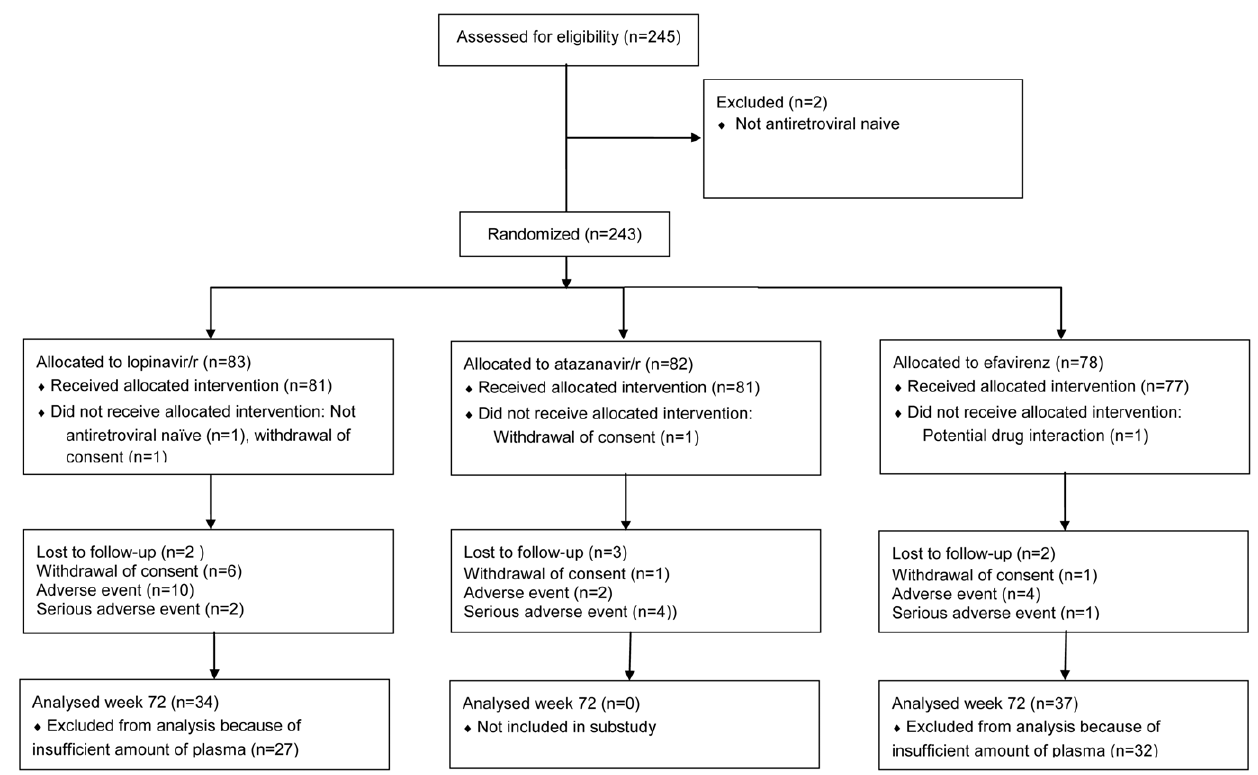
Figure 1. Trial profile and reasons for discontinuations in each group.